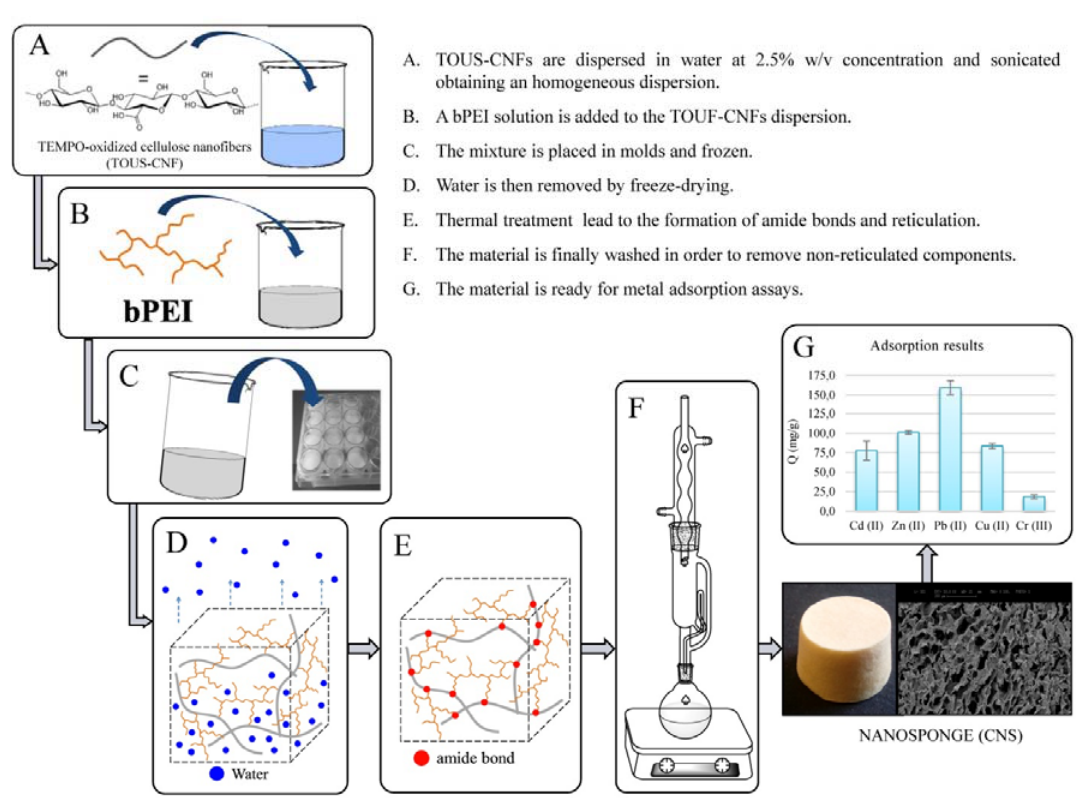
Figure 3. Synthetic process of TOUS ‐ CNFs/bPEI adsorbent nanosponges.